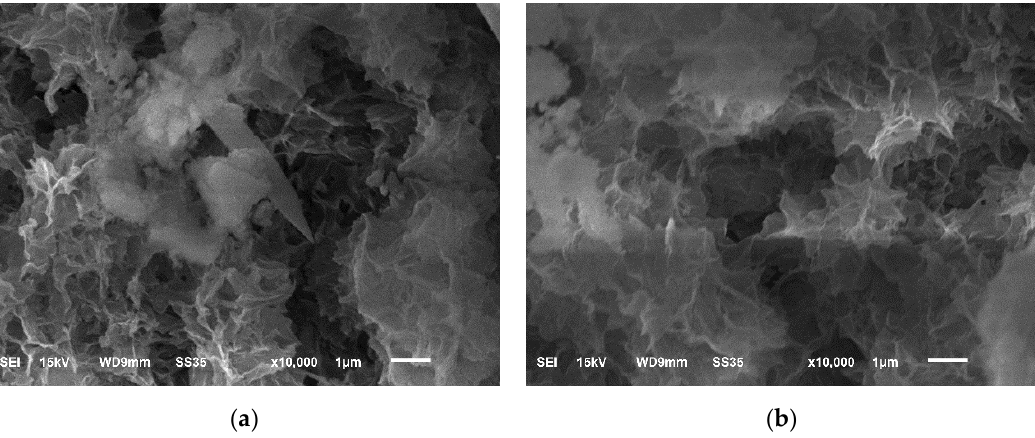
Figure 8. The scanning electron micrograph of the mortar: ( a ) the control, ( b ) the mortar with 2% content of EVA. For the increase in content of EVA, the air-entraining effect of the EVA is reflected, and the porosity of the mortar is increased. This effect is much greater than the cohesion of the EVA, causing the strength to decrease. The reduction in the density of the thermal insulation mortar, allowed this to achieve the thermal insulation effect, and have